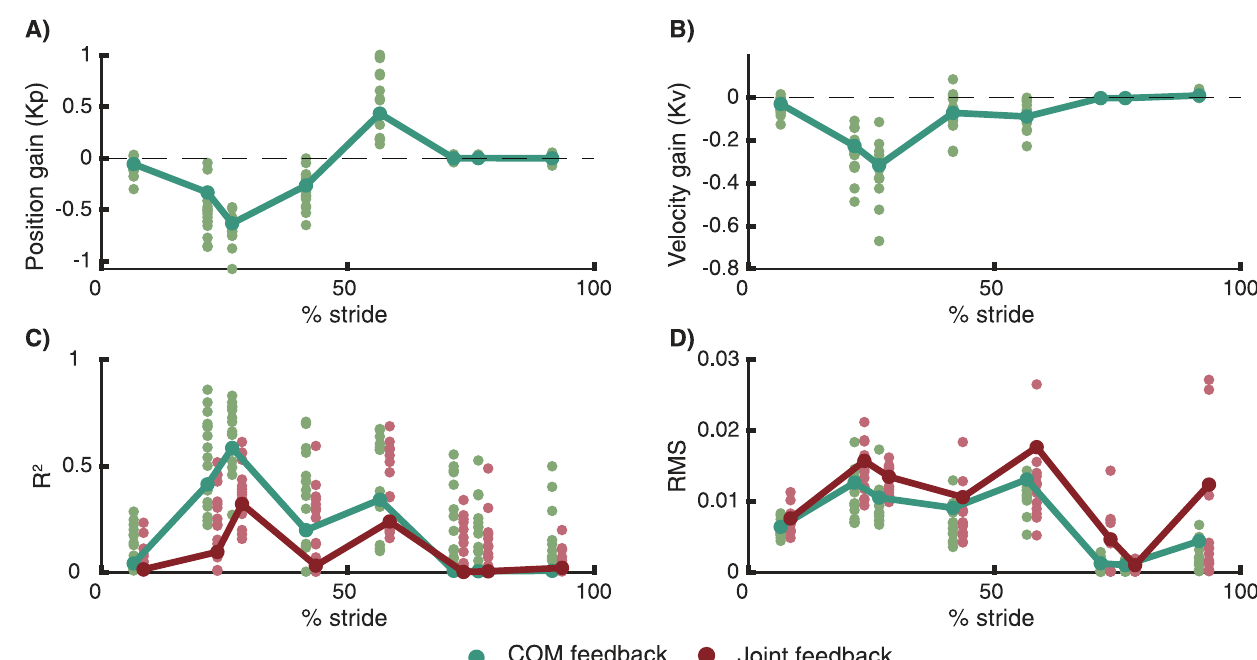
Fig 5. Perturbed walking (data from [10]). Gain modulation in response to beltspeed perturbations applied at different phases in the gait cycle. Reconstruction of the reactive ankle moments is better in a model with delayed COM feedback (green) compared to local joint level feedback (R) (C,D). The proportional feedback of COM position (A) and COM velocity (B) is modulated during the gait cycle. The bars and large dots represent feedback gains estimated based on the pooled data over all subjects. The small dots represent gains estimation in individual subjects. The perturbation onset timing in the gait cycle had a significant influence on the position gains, velocity gains, R 2 and RMS